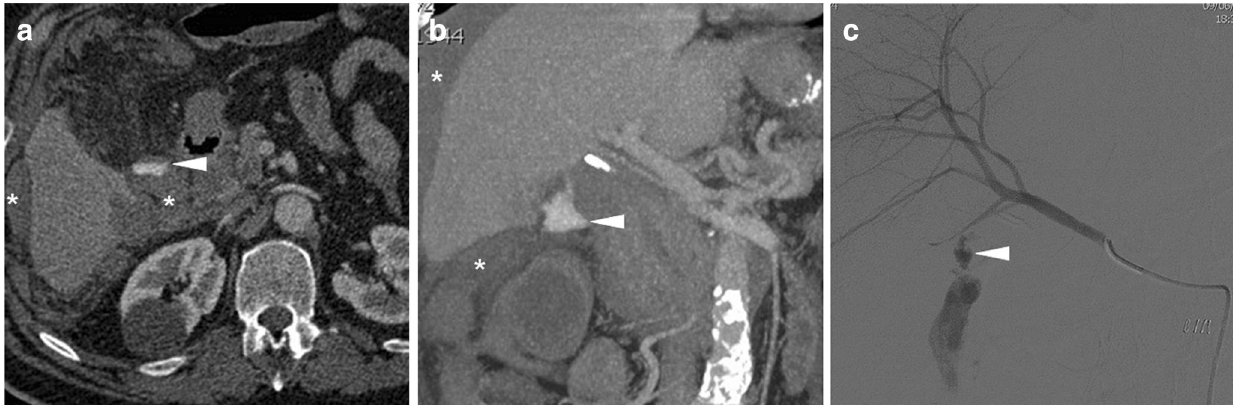
Fig.14 Activehaemorrhagediagnosed48 h after laparoscopiccholecystectomy as extravascular contrast B blush ^ ( arrowheads ) onarterial ( a ) and portal venous ( b ) CT images, within infrahepatic haematoma (*), which was confirmed angiographically ( c ) and effectively treated by